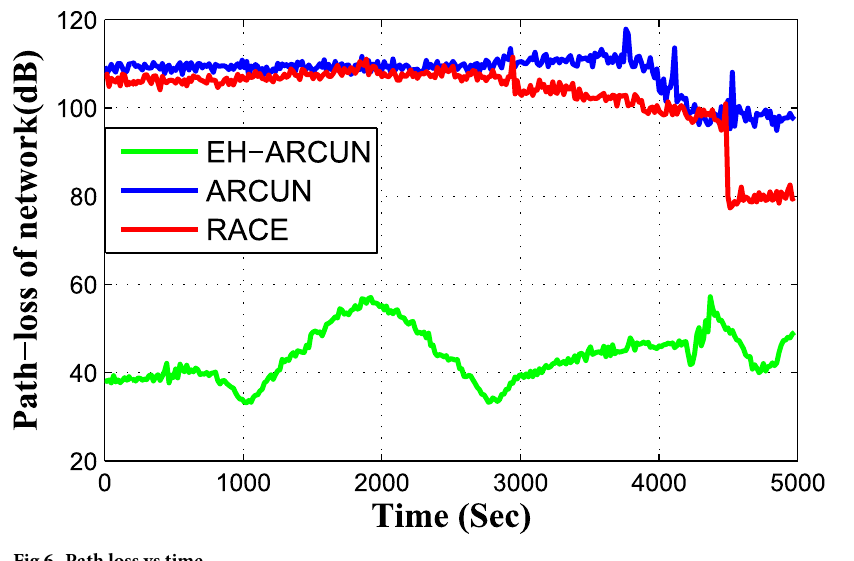
Fig 6. Path loss vs time.